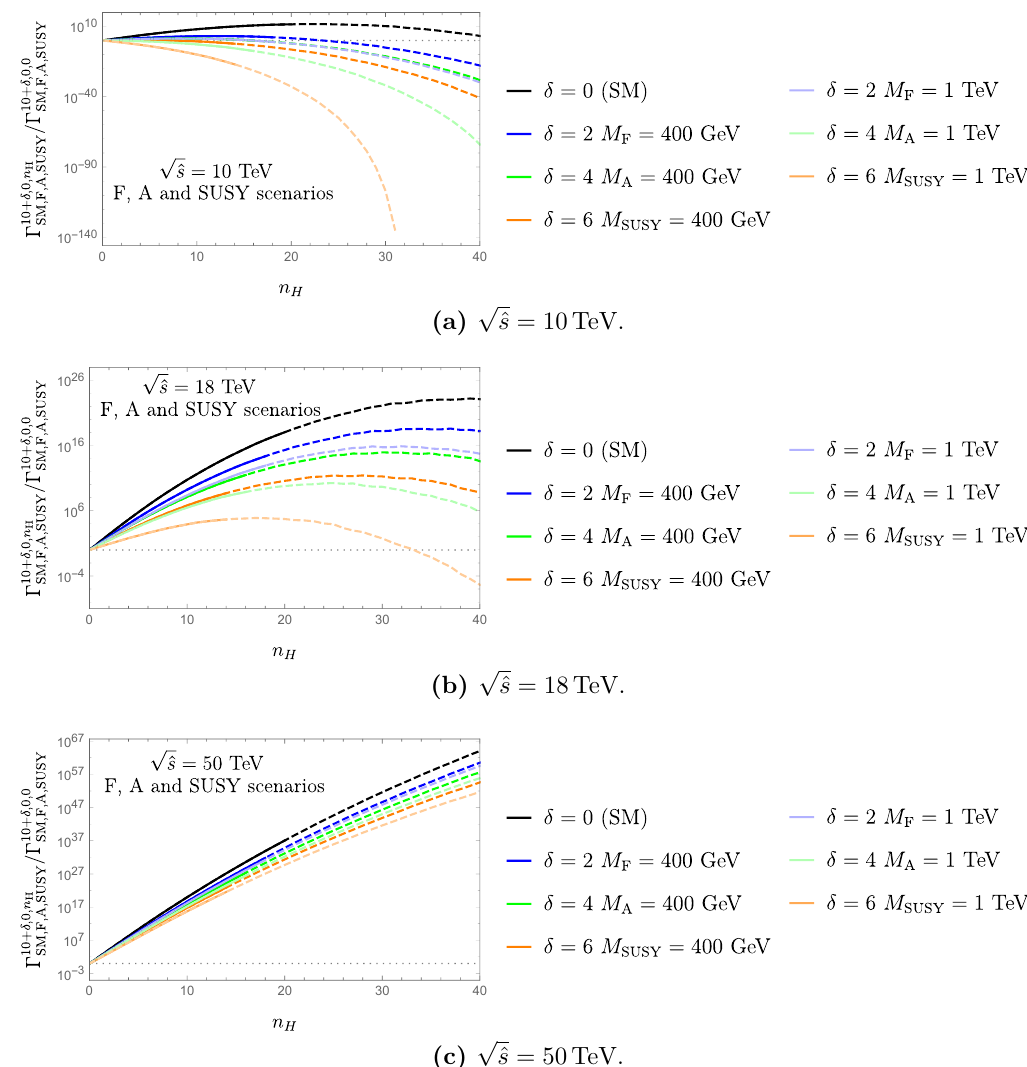
p ^ s and new fermion masses M